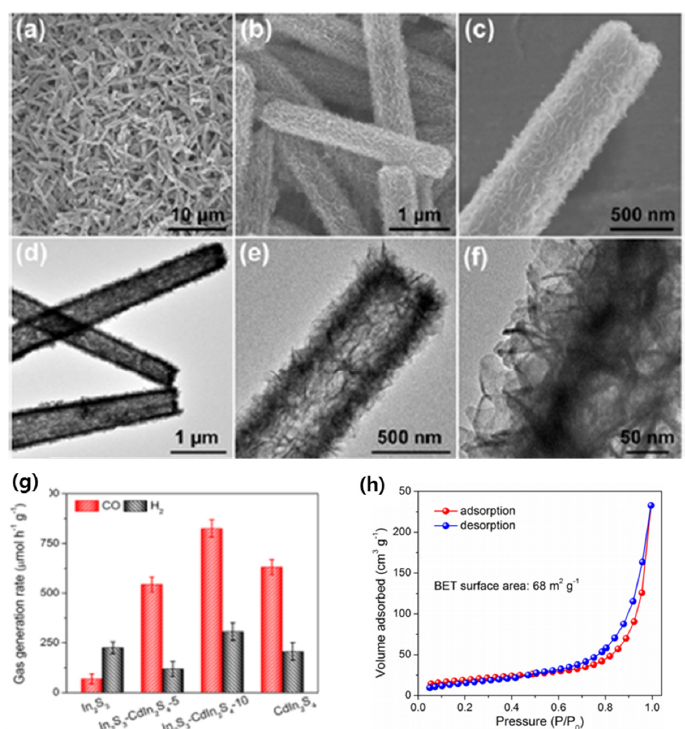
Figure 12. (a − c) Field emission SEM (FESEM) images, (d − f) TEM images, (g) CO 2 photoreduction performance and (h) N 2 adsorption isotherms of In 2 S 3 ‐ CdIn 2 S 4 hierarchical nanotubes (with optimized sample), reprinted with permission from